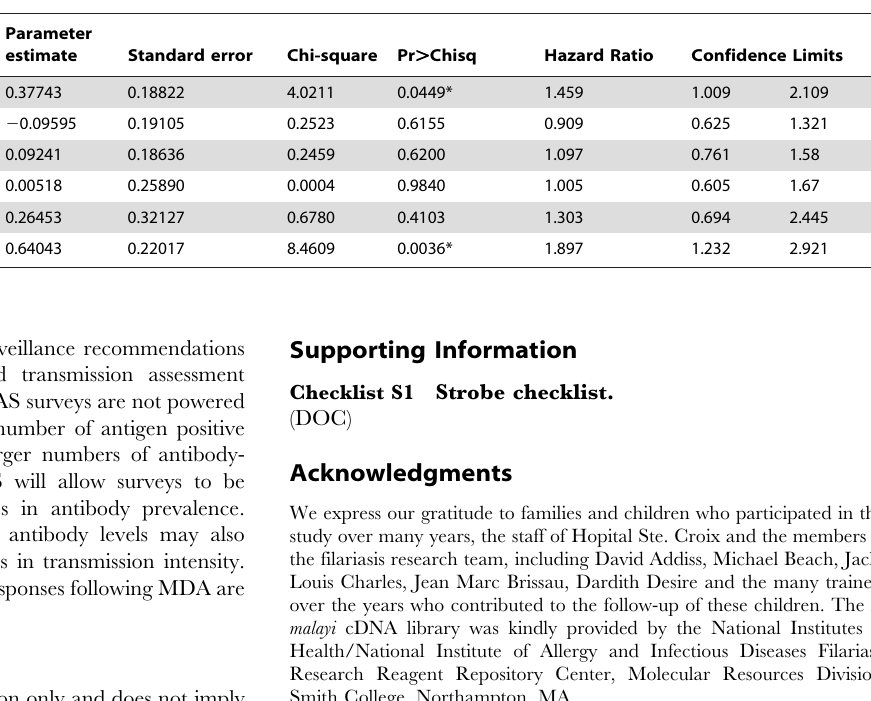
Table 5. Cox proportional hazards model for initial Bm14 antibody